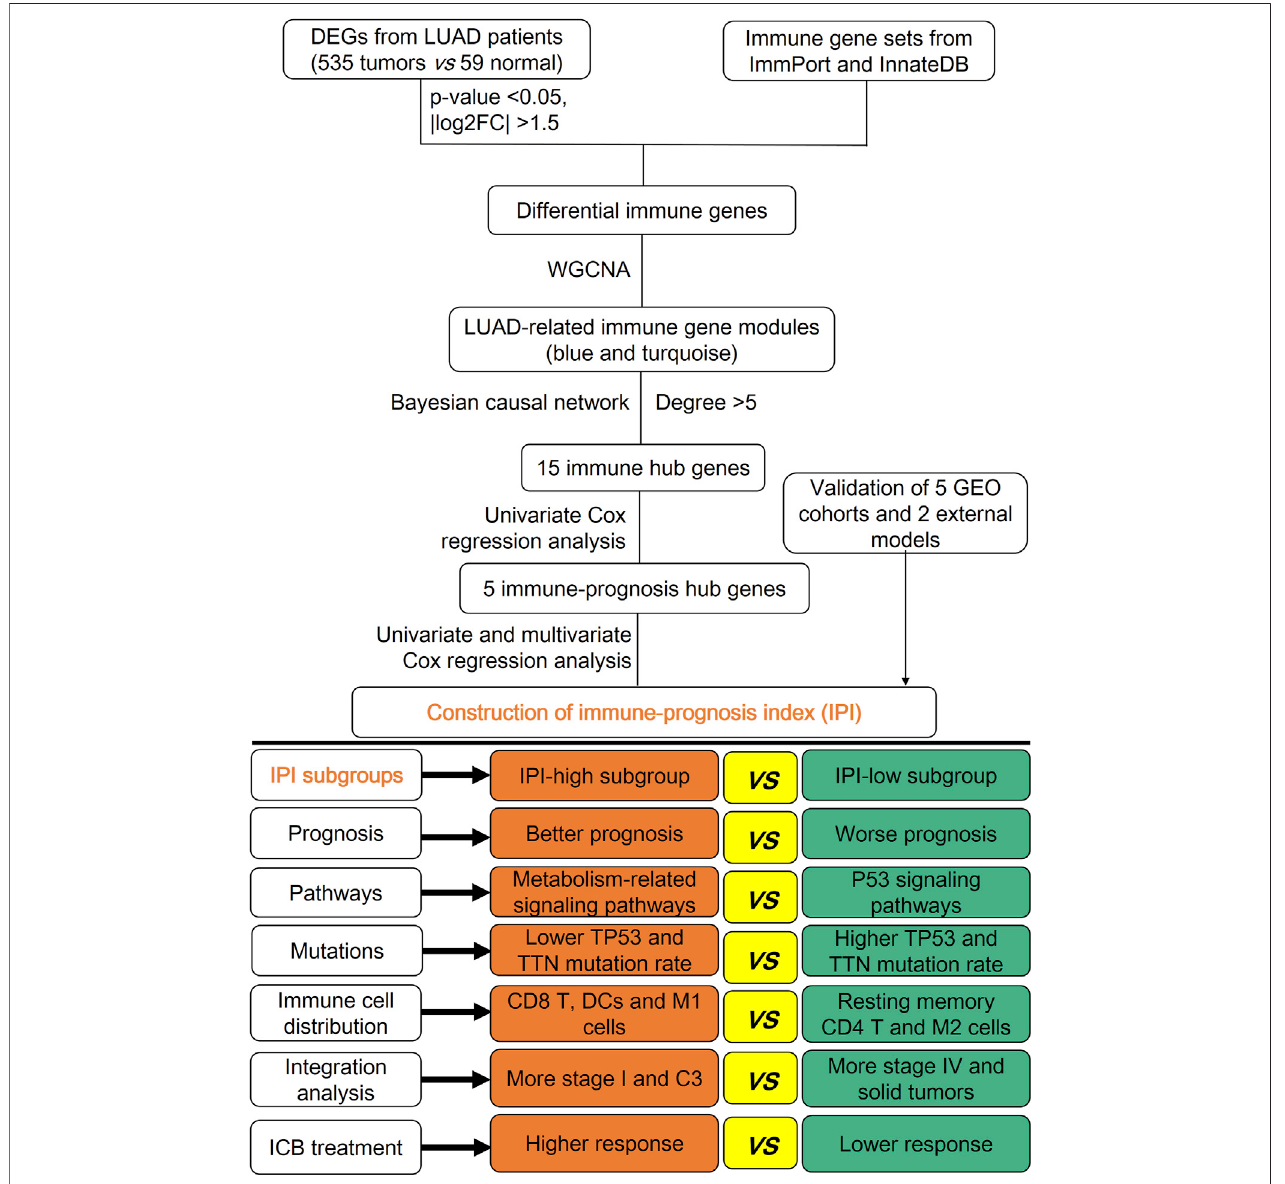
FIGURE 1 | Graphical abstract for the construction, veri fi cation and characterization of IPI in LUAD.